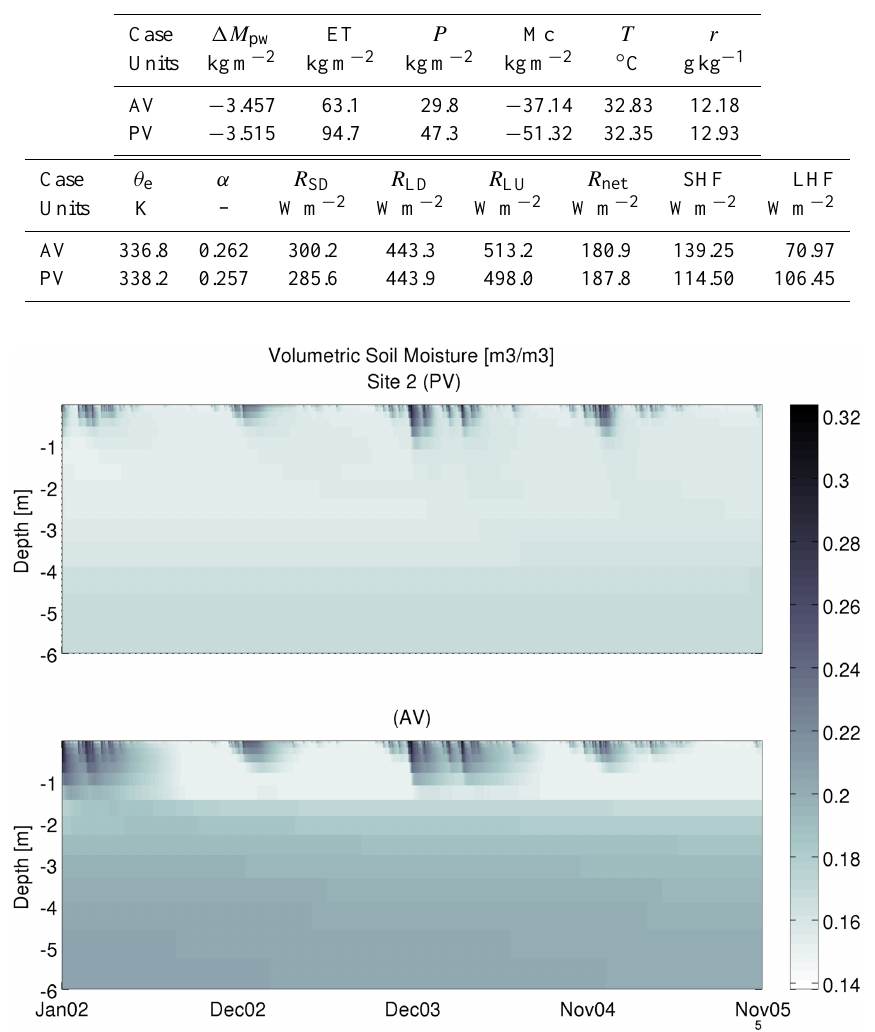
Table 3. Hydrologic monthly means within the bounded area above the Pará case study, September 2003. Total change in column precipitable water for the month per square meter (cid:49)M pw , evapotranspiration ET, precipitation P and resolved moisture convergence Mc, 55m air temperature T , mixing ration (55m) r , equivalent potential temperature θ e , surface albedo to shortwave radiation α , downwelling shortwave radiation R SD , downwelling longwave radiation R LD , upwelling longwave radiation R LU , net surface radiation R net , sensible heat flux SHF and latent heat flux LHF.